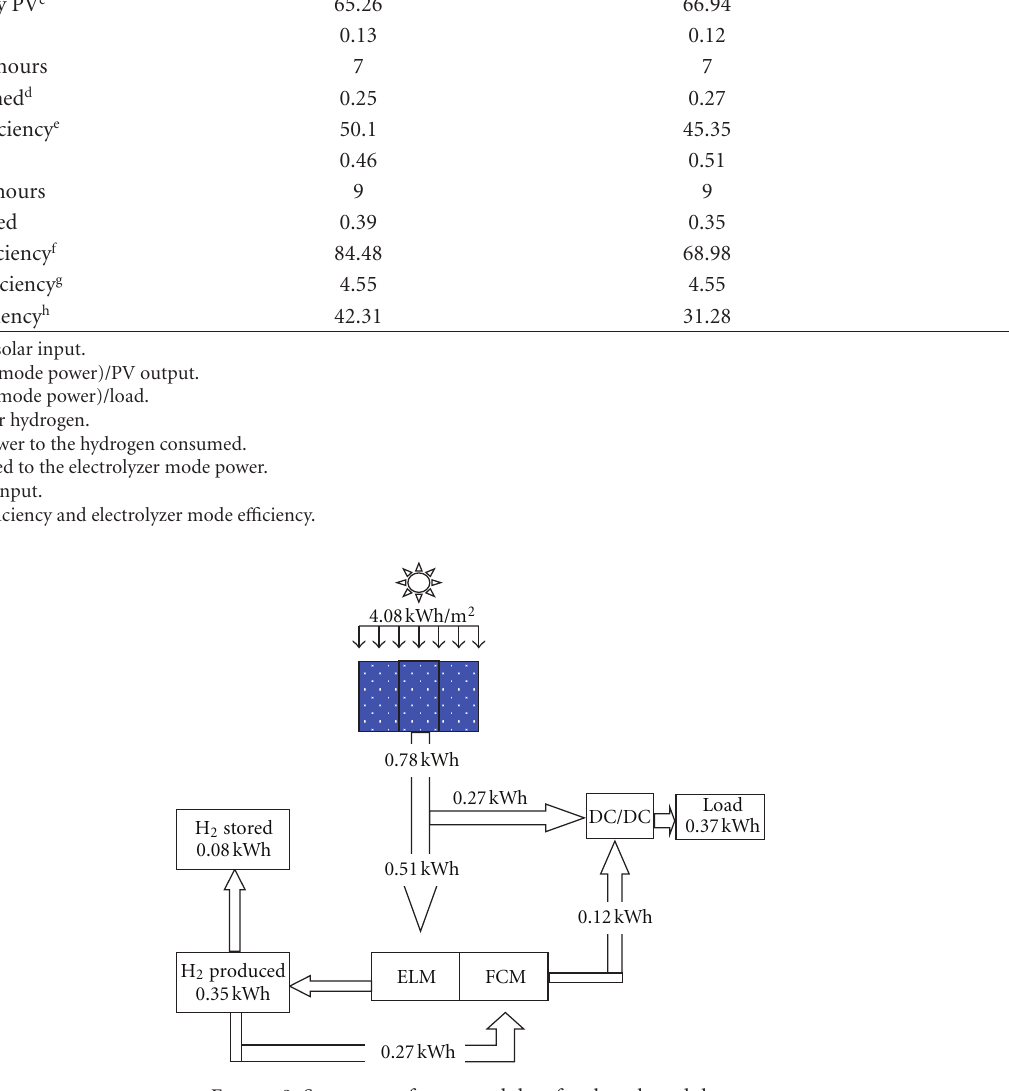
Figure 9: Summary of measured data for the selected